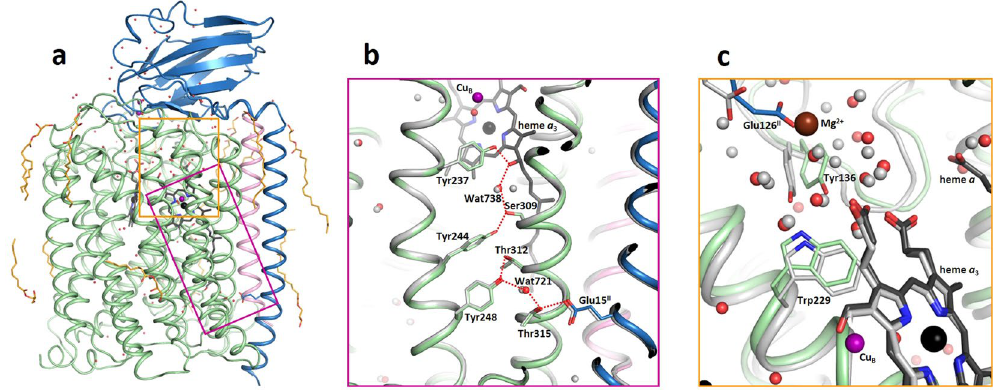
Figure 2. Room-temperature SFX structure of ba 3 C c O. ( a ) Overall structure with subunit I in green, subunit II in blue, subunit IIa in pink, heme groups in black, copper ions in purple and lipids in orange. ( b ) Close-up view of the proton pathway where the SFX structure is shown in green/blue/pink and the cryo-LCP structure (PDB code 3S8G) is shown in grey. Water molecules are shown in red (SFX) and grey (cryo-LCP). ( c ) Close-up view of the area around the presumed proton-loading site. The SFX structure is shown in green/blue and the bovine heart aa 3 -type C c O (PDB code 3WG7) in grey. The magnesium ion of the bovine heart structure is shown in brown. Water molecules are shown in red (SFX) and grey (bovine heart). Heme a 3 is shown in black (SFX) and grey (bovine heart). The amino acid numbering refers to the ba 3 C c